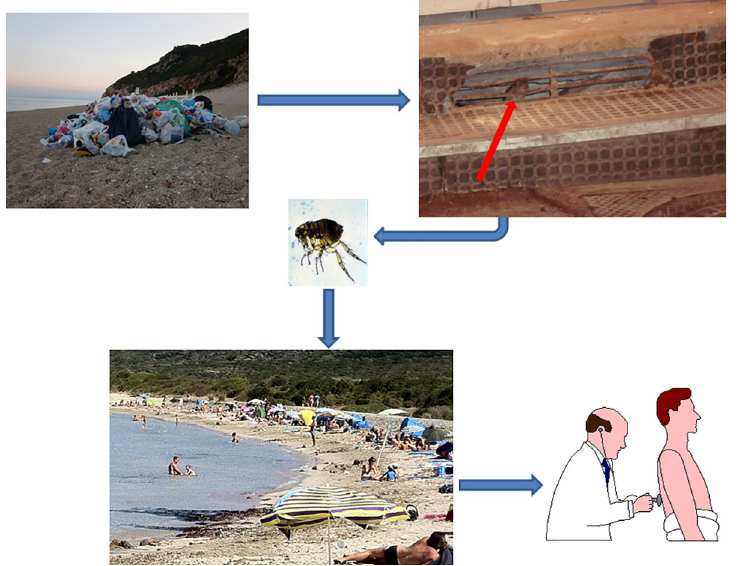
Fig 2. Sunbathing on the beach and murine